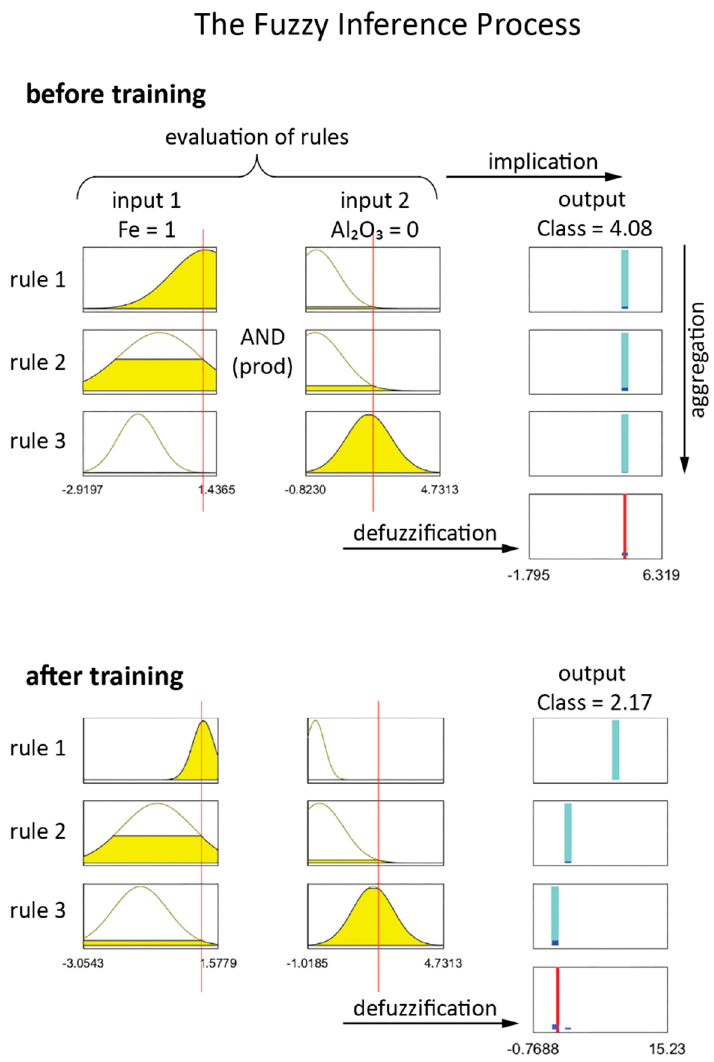
Figure 7. Illustration of the fuzzy inference process regarding the rule evaluation and output value generation. The three rules and three membership functions per input variable are the result of initial fuzzy c -means clustering. All rules are evaluated simultaneously and a logical operator and method (AND/PRODUCT in this case) as well as the implication method applied to the rule evaluation results. The aggregated fuzzy output set is finally defuzzified by choosing value of the weighted average. In this example, the input value is high in iron and high in aluminum and its membership in terms of iron is to cluster one and partly to cluster 2 but in terms of aluminum it is to cluster 3. The minimum (implication method) is chosen to truncate the output function (which is a linear function in this case). The truncated outputs are aggregated into a single fuzzy set of which the weighted average value is chosen as he crisp output (class) value.